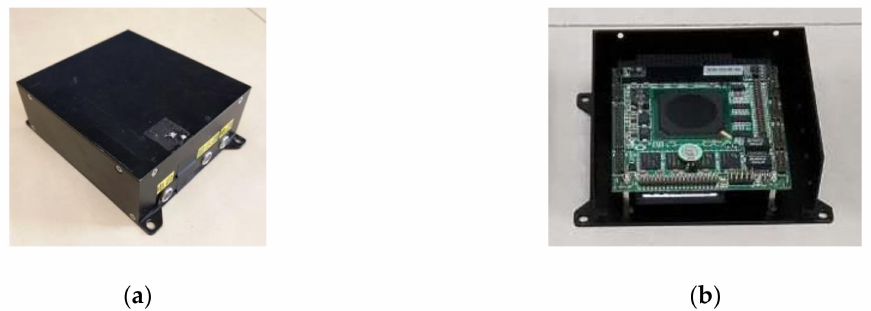
Figure 10. UAVs used for flight verification.